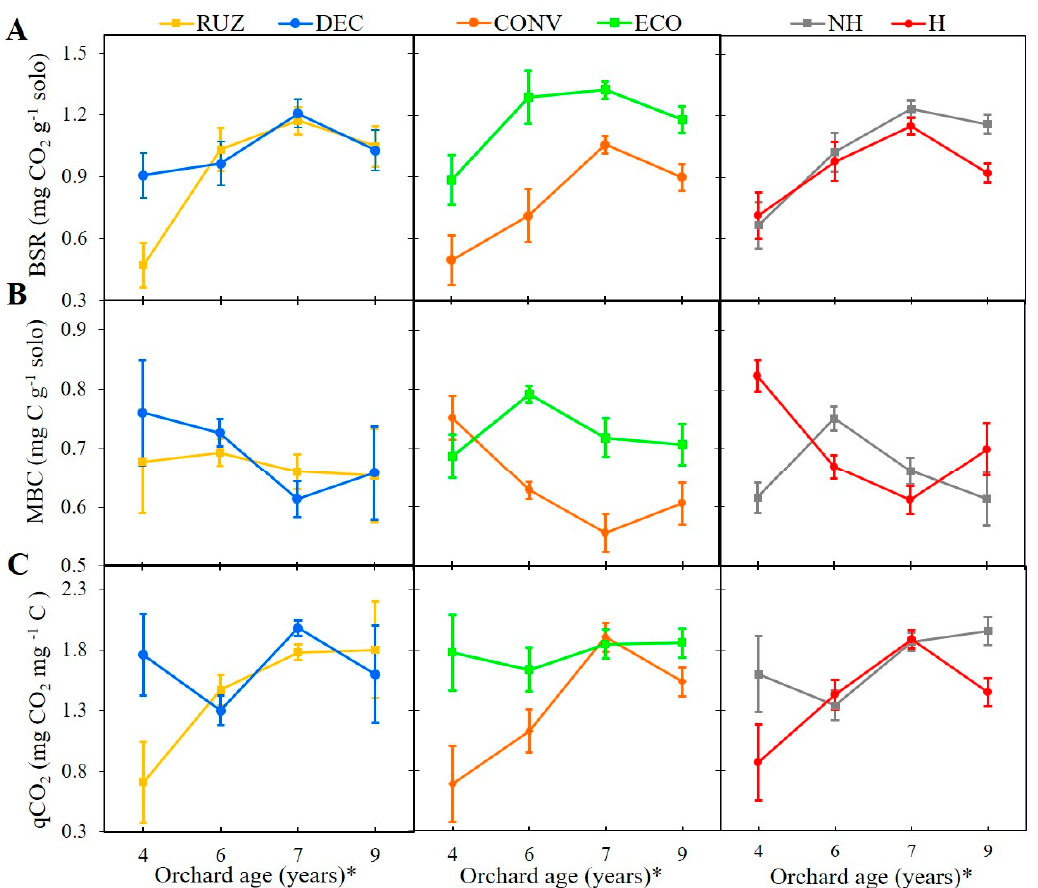
Figure 3. Basal soil respiration, BSR ( A ), microbial biomass carbon, MBC ( B ), and metabolic quotient, qCO 2 ( C ), tested with different cover crops, mowers, and the use of glyphosate (Mogi Mirim, São Paulo, 2014–2019). Legend: RUZ = Urochloa ruziziensis , DEC = U. decumbens , ECO = ecological mower, CONV = conventional mower, H = glyphosate herbicide (1080 g ae. ha − 1 ), NH = no herbicide. The significant difference was accounted for by the Tukey test ( p < 0.05), and the error bars represent the minimal significant difference. * Orchard age: growing season 2014–2015 (4), 2016–2017 (6), 2017–2018 (7), and 2019–2020 (9).